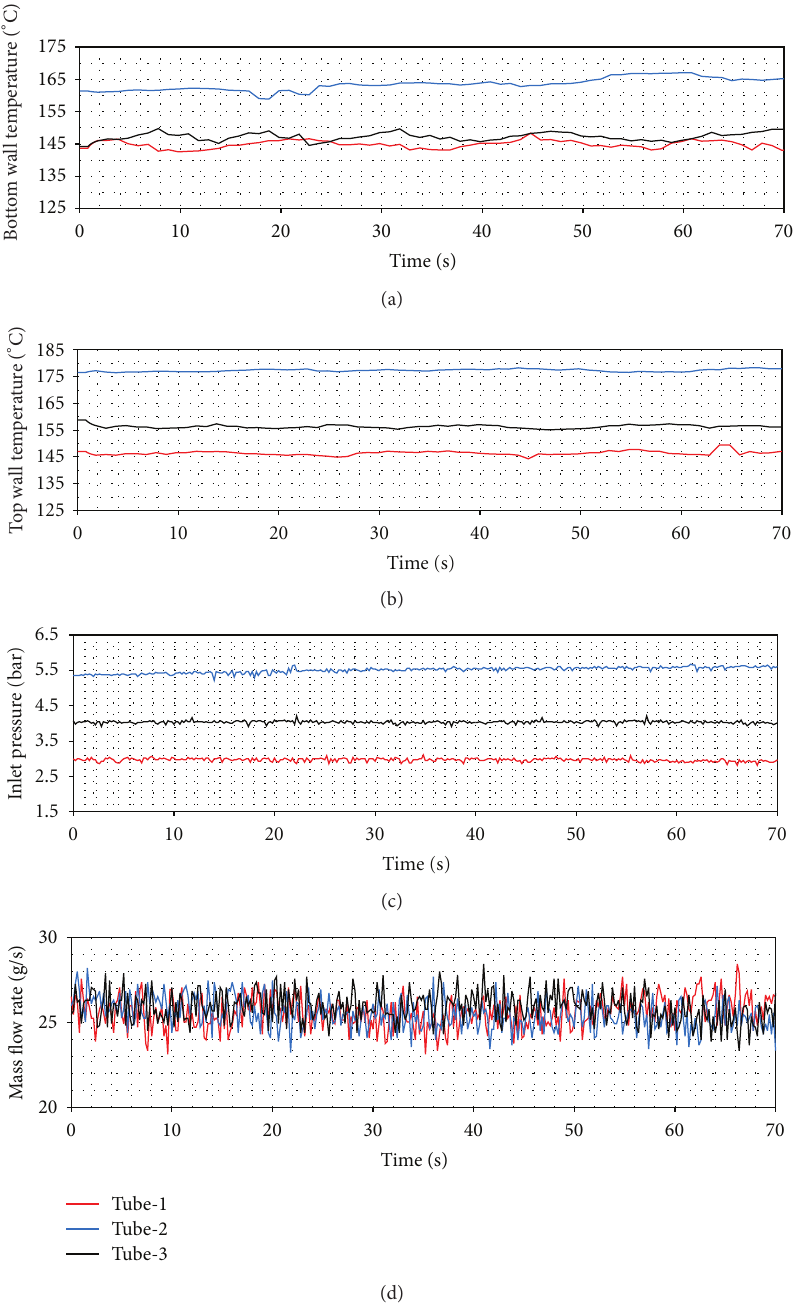
F 14: Density wave oscillations (